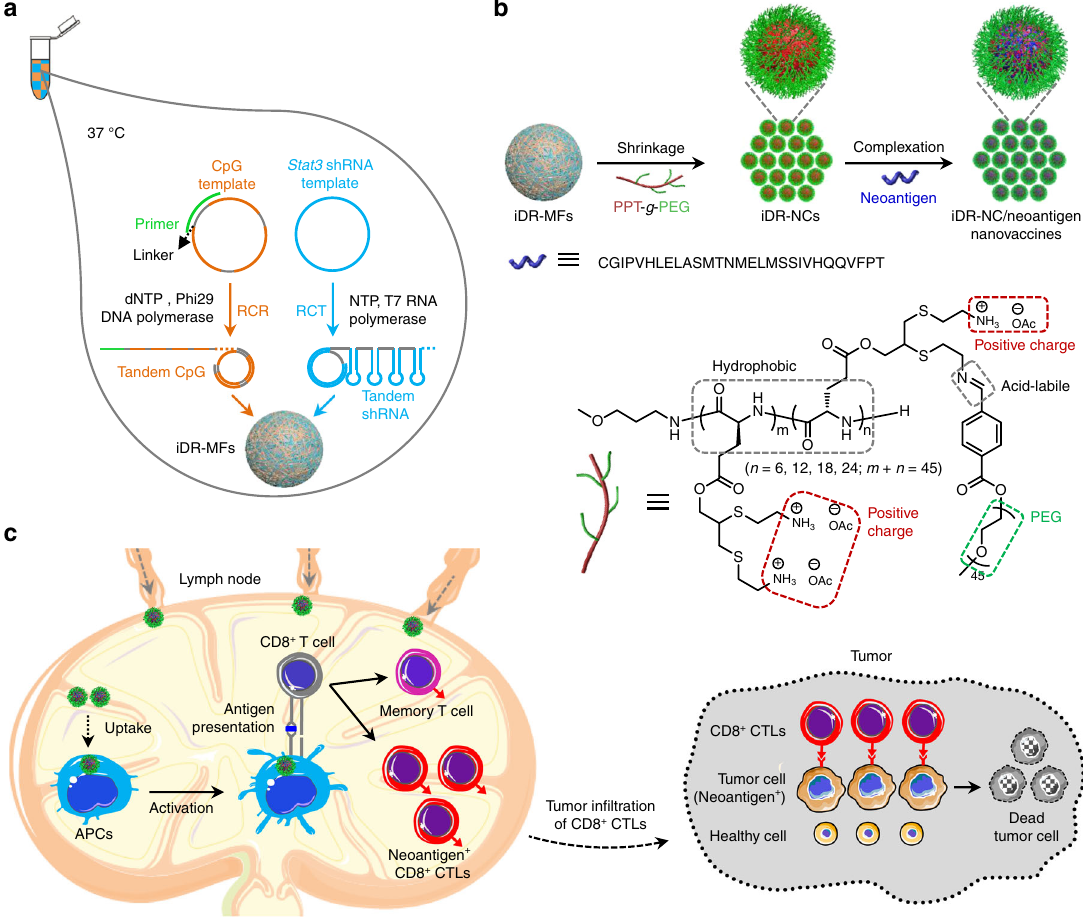
Fig. 1 Schematics of iDR-NC/neoantigen nanovaccines for synergistic tumor immunotherapy. a Concurrent RCR and RCT in the same solution generated tandem CpG and Stat3 shRNA, which were self-assembled into intertwining DNA-RNA MFs. b The above MFs were shrunk by PPT- g -PEG to form iDR-NCs, which was further loaded with tumor-speci fi c neoantigen via hydrophobic interactions between peptide antigens and hydrophobic PPT moieties. c In immunocompetent mice, iDR-NCs/neoantigen complexes were delivered into APCs in draining LNs, elicited potent and durable neoantigen-speci fi c T cell responses, and inhibited tumor